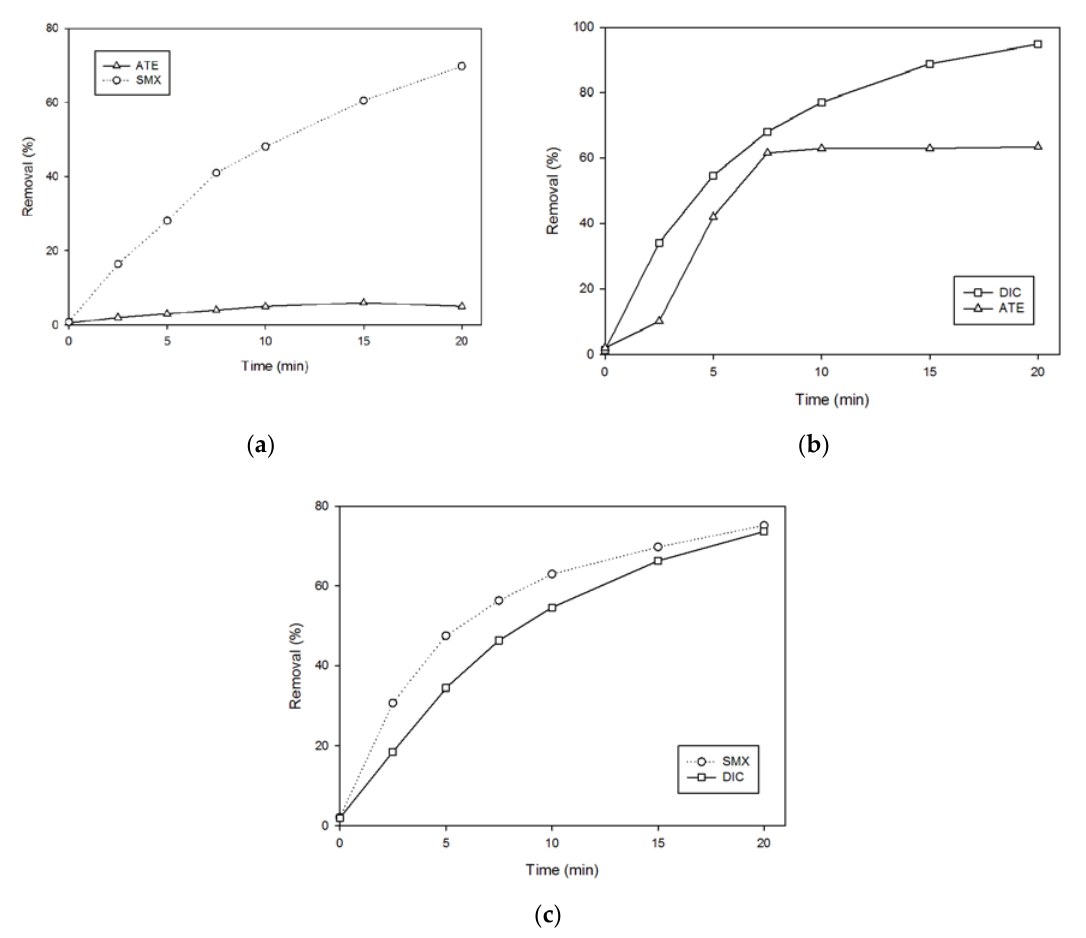
Figure 5. Removal efficiencies of dual pharmaceuticals in a 1 L batch reactor with 5-cell graphite electrodes ([Phar.] 0 = 100 µM, [NaCl] = 0.01 M, I = 0.5 A). ( a ) ATE + SMX; ( b ) DIC + ATE; ( c ) SMX + DIC.